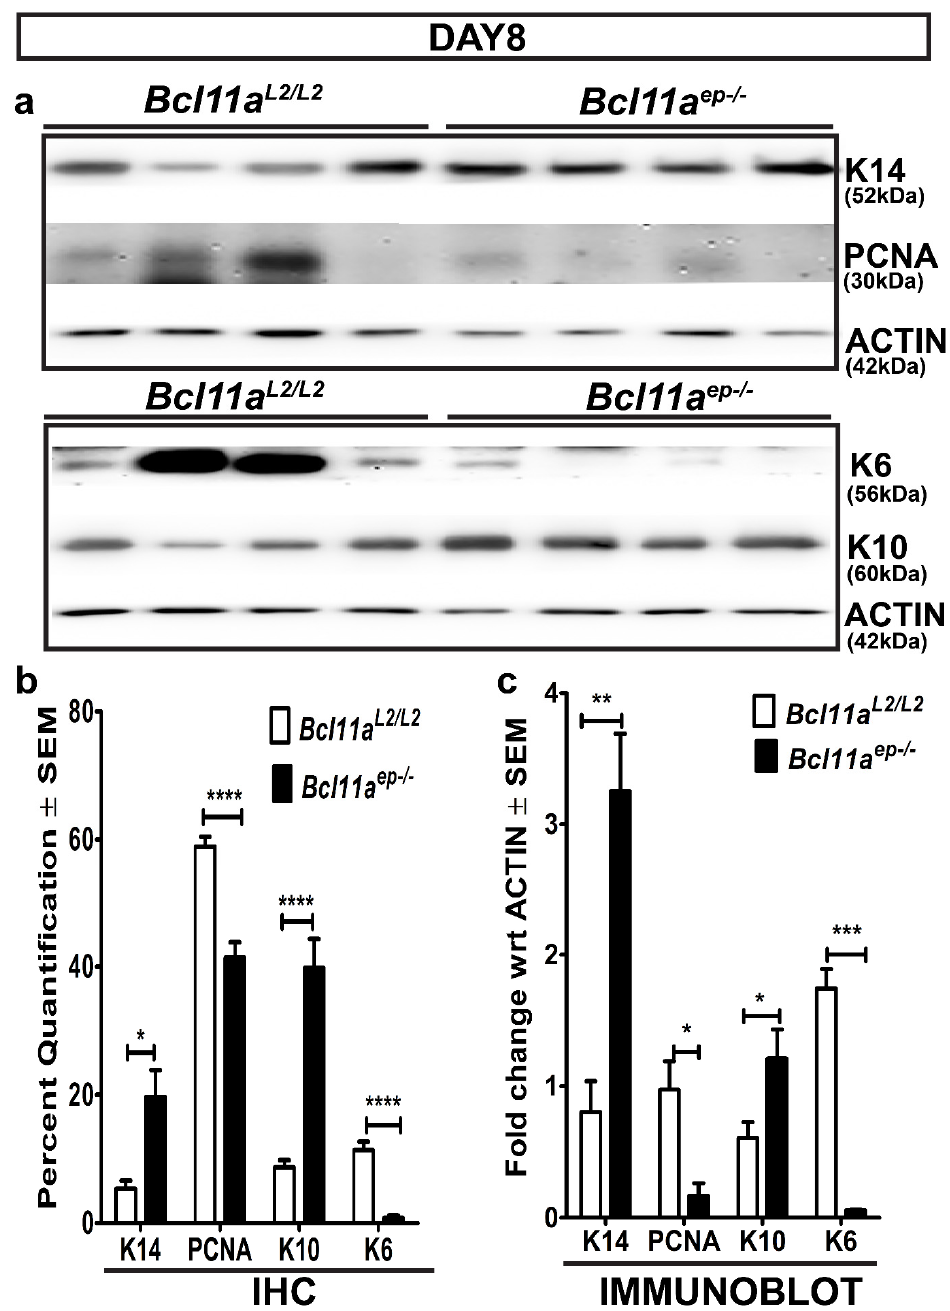
Figure 5. Epidermis specific Bcl11a deletion alters expression profile of key markers of epidermal homeostasis on Day 8 post wounding. ( a ) Immunoblot analyses of basal keratinocyte marker (K14), active proliferation marker (PCNA), activated keratinocyte marker (K6), and early differentiation marker (K10) expression in the dorsal skin of Bcl11a L2/L2 versus Bcl11a ep − / − adult mice on Day 8 post wounding. β -actin was used as the internal control. ( b ) IHC quantification displaying the Day 8 post wounding expression status of epidermal markers (K14, PCNA, K10 and K6) in Bcl11a L2/L2 versus Bcl11a ep − / − mice. ( c ) Immunoblot quantification showing the relative fold change in the expression status of epidermal markers (K14, PCNA, K10 and K6) in Bcl11a L2/L2 versus Bcl11a ep − / − Day 8 wounds. N = 4, where N represents the number of animals of each genotype ( Bcl11a L2/L2 or Bcl11a ep − / − ) being involved in the study. All western blots were repeated 2–3 times. * p < 0.1, ** p < 0.01, *** p < 0.001, **** p <